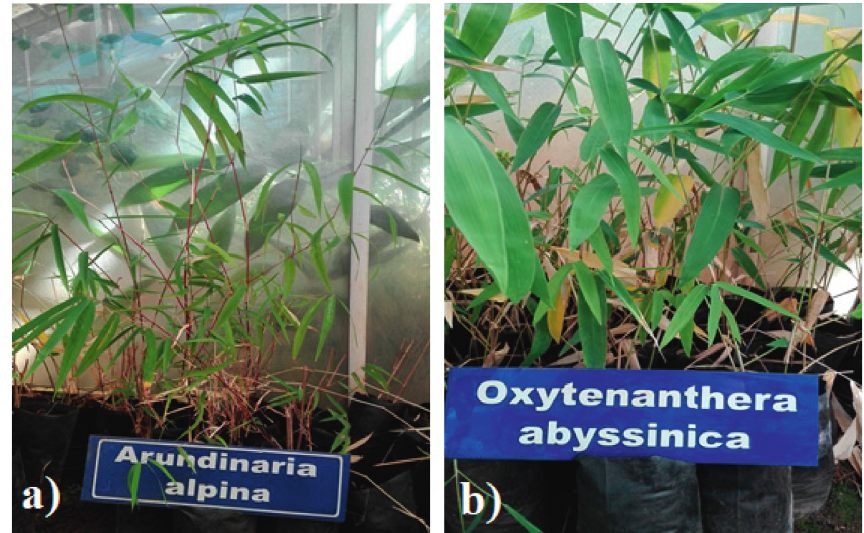
Figure 8: O. alpina (a) and O. abyssinica (b) seedlings at CEE-FRC greenhouse in January 2021, Addis